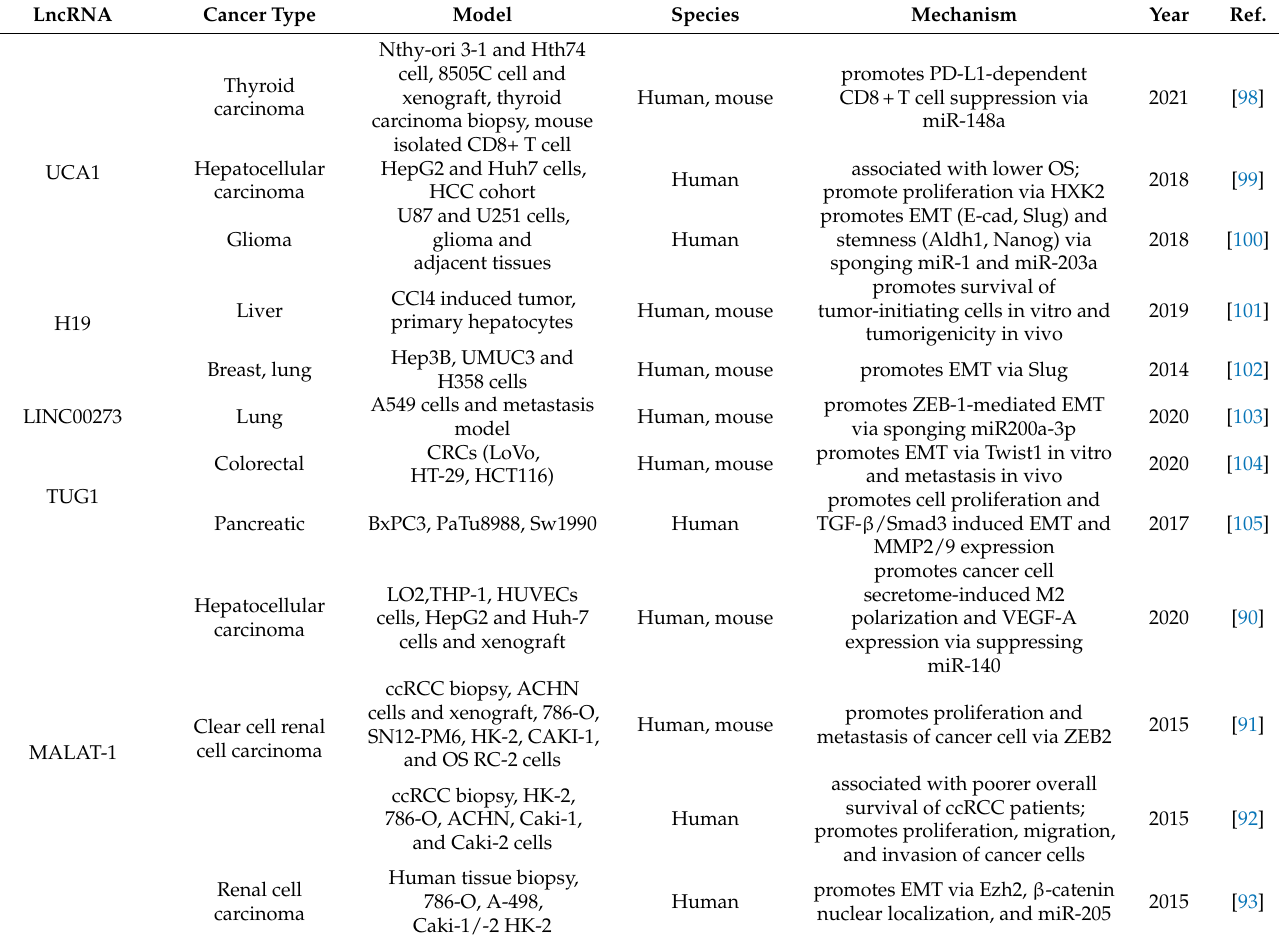
Table 3. TGF- β associated lncRNAs in